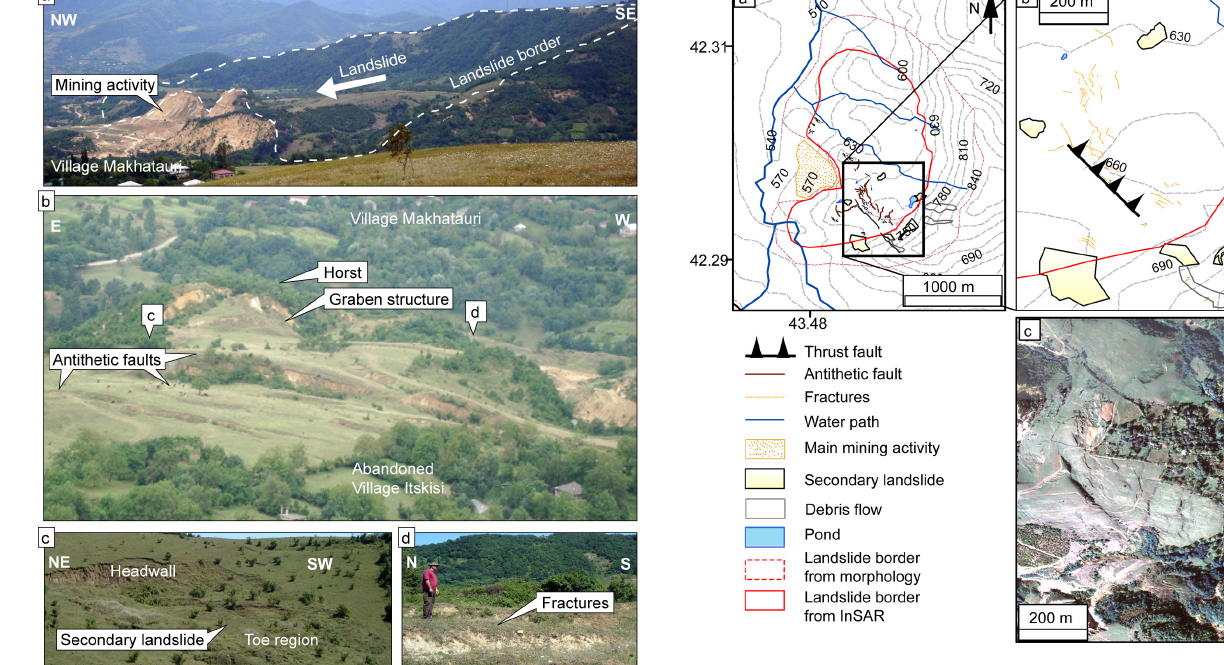
Fig. 7. Simplified structural map of the Itskisi landslide. Contour lines are based on SRTM DEM and have 30-metre intervals. The features mapped are presented in the legend. The possible body of the landslide is within the red line (a) . The red dashed line shows the landslide boundary detected from the morphology. (b) is a de- tail of the black box in (a) . Aerial photograph shows the fissured, hilly surface of the landslide (c) . Structures are well aligned with the orientation of the Okada plane, as obtained from modelling of the landslide process (Fig. 8, Table 1, strike